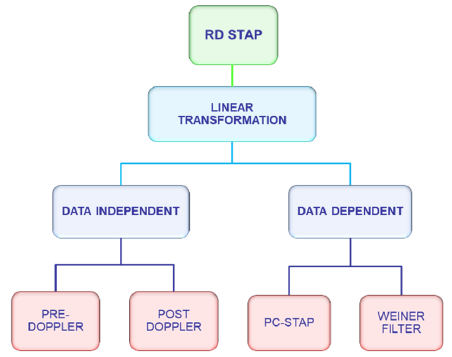
Figure 2. Reduced dimension space time adaptive processing (STAP) algorithms.